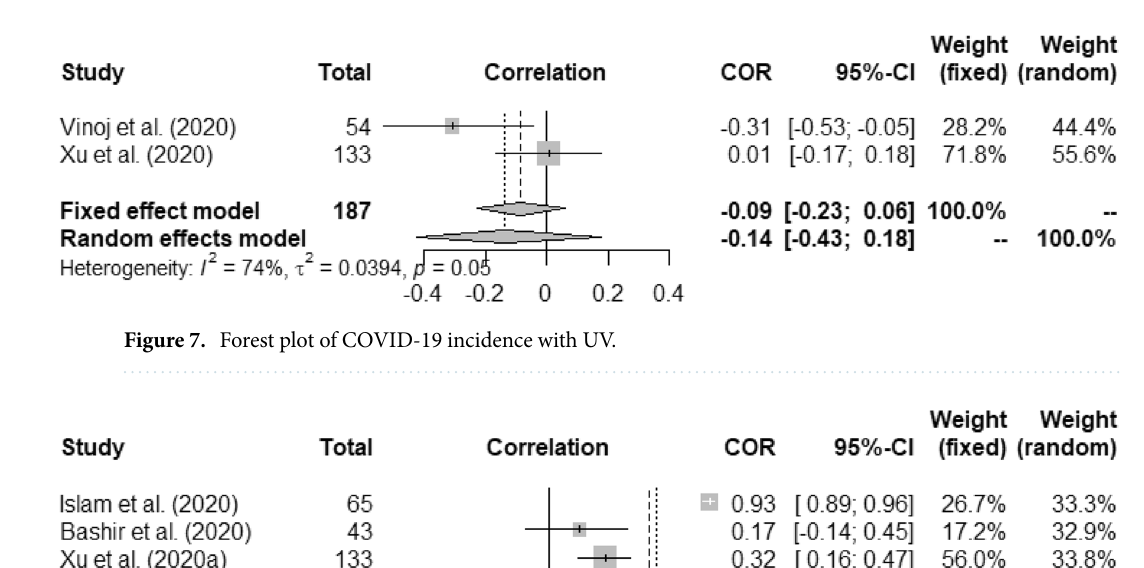
Figure 6. Forest plot of COVID-19 incidence with rainfall.